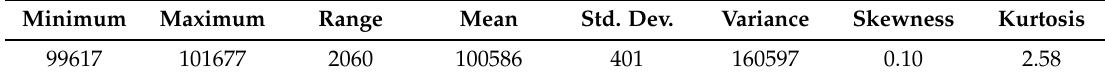
Table B7. Statistics of the atmospheric pressure distribution